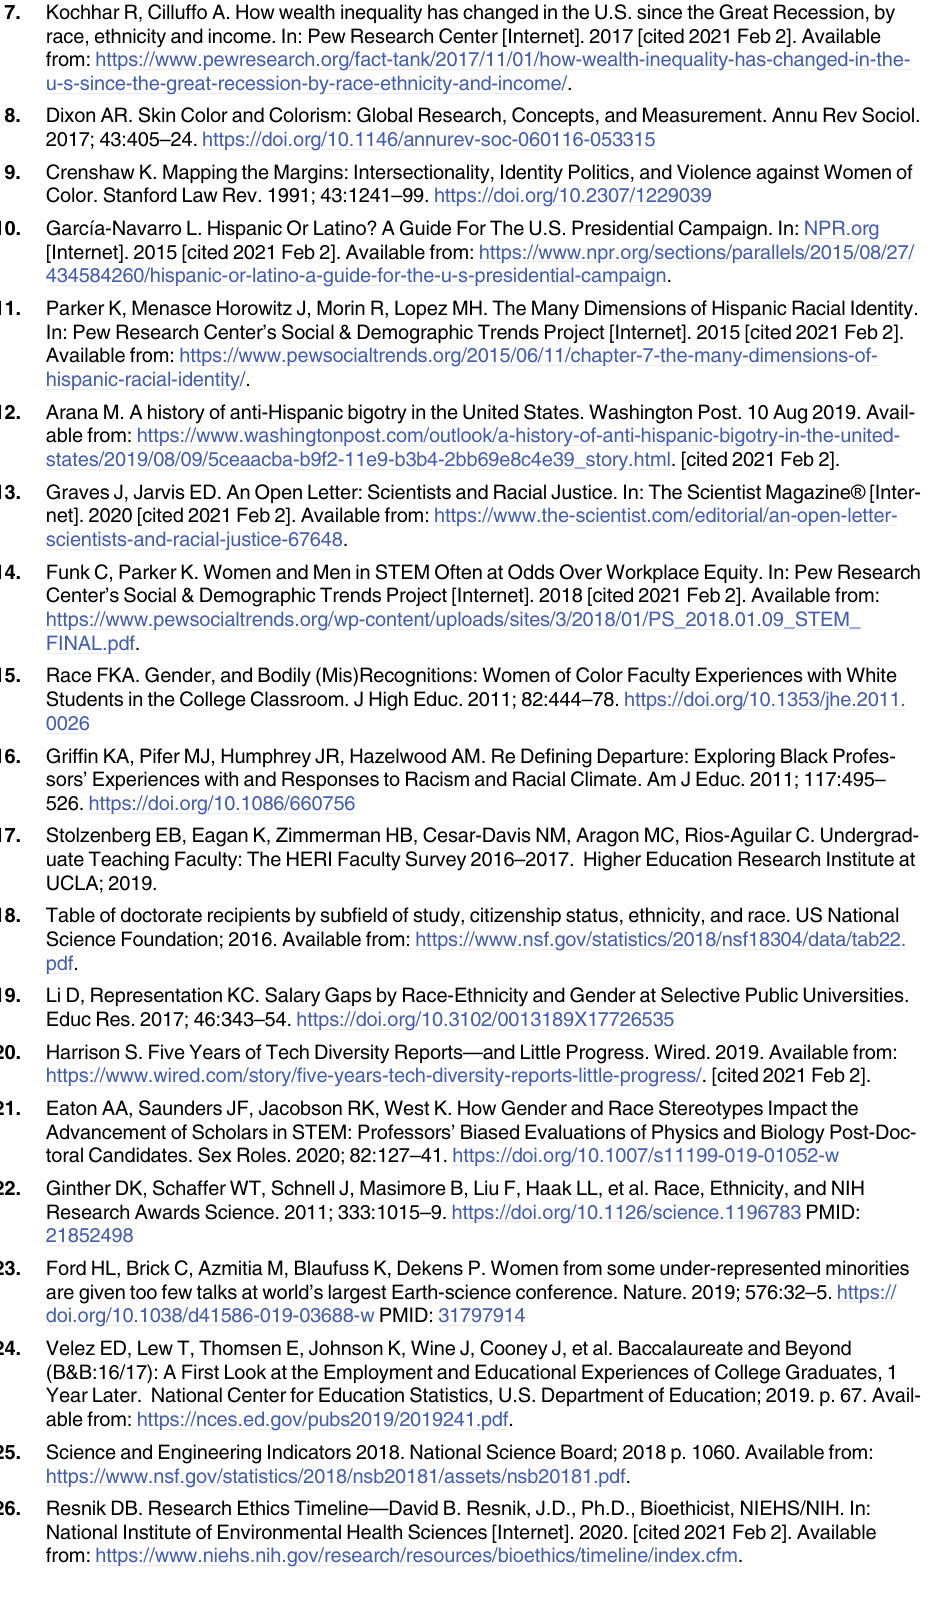
18. Table of doctoraterecipients by subfield of study, citizenshipstatus, ethnicity, and race. US National Science Foundation; 2016. Available from: https://www.nsf.gov/statistics/2018/nsf18304/data/tab22.